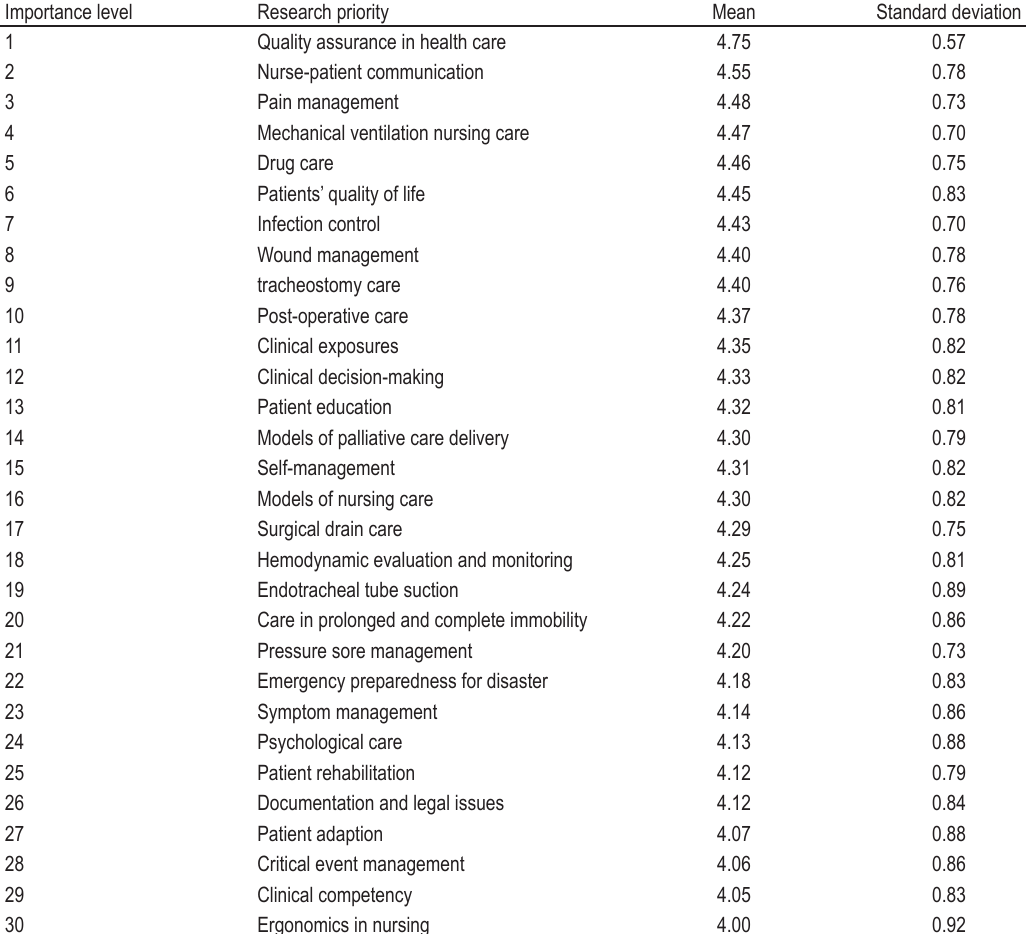
TABLE 2. The final ranking of the research priorities of the Evidence‑Based Nursing Care based on Delphi survey Importance